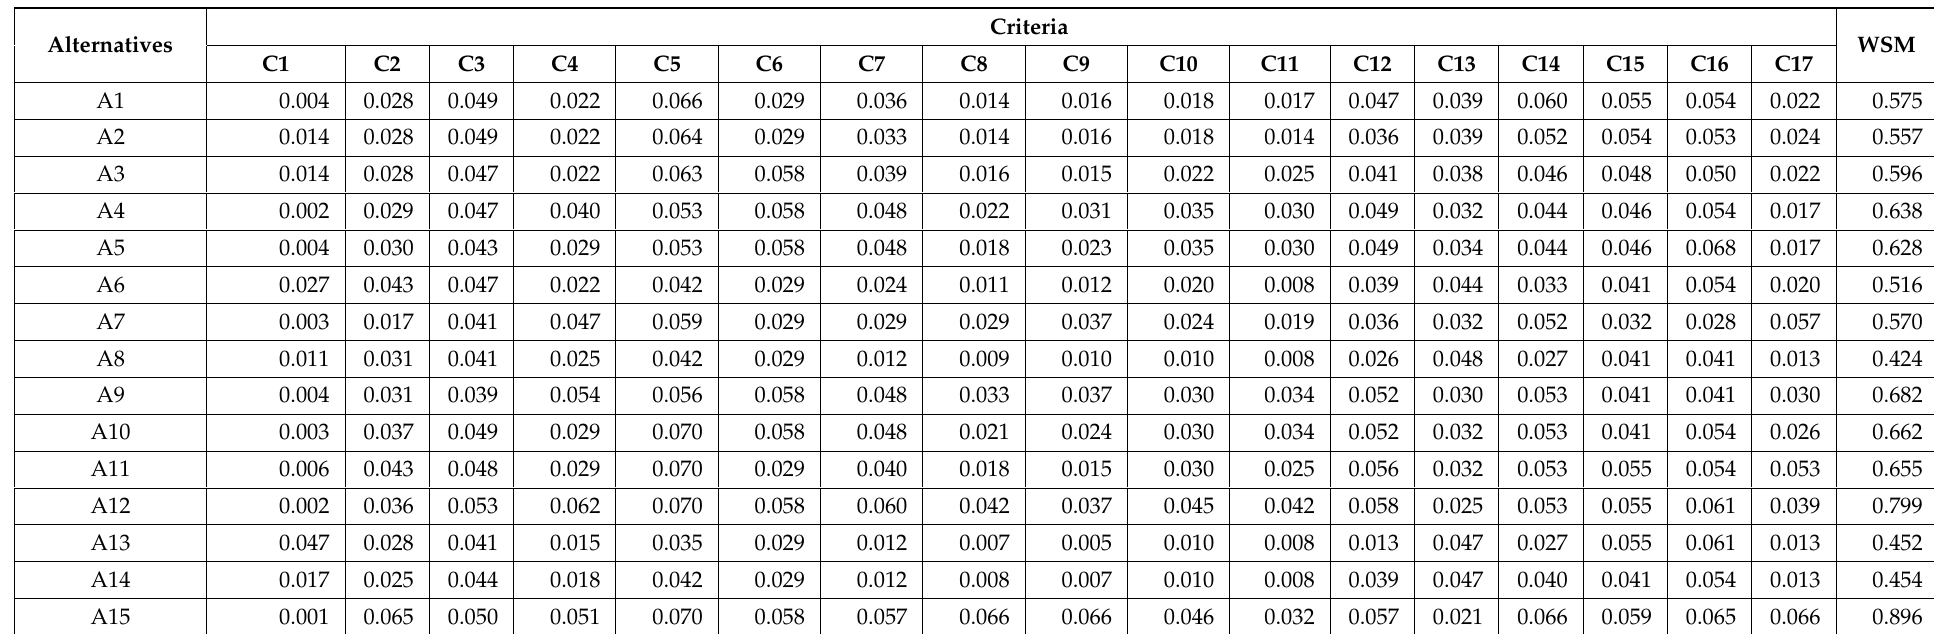
Table 5. Matrix for the weighted sum method